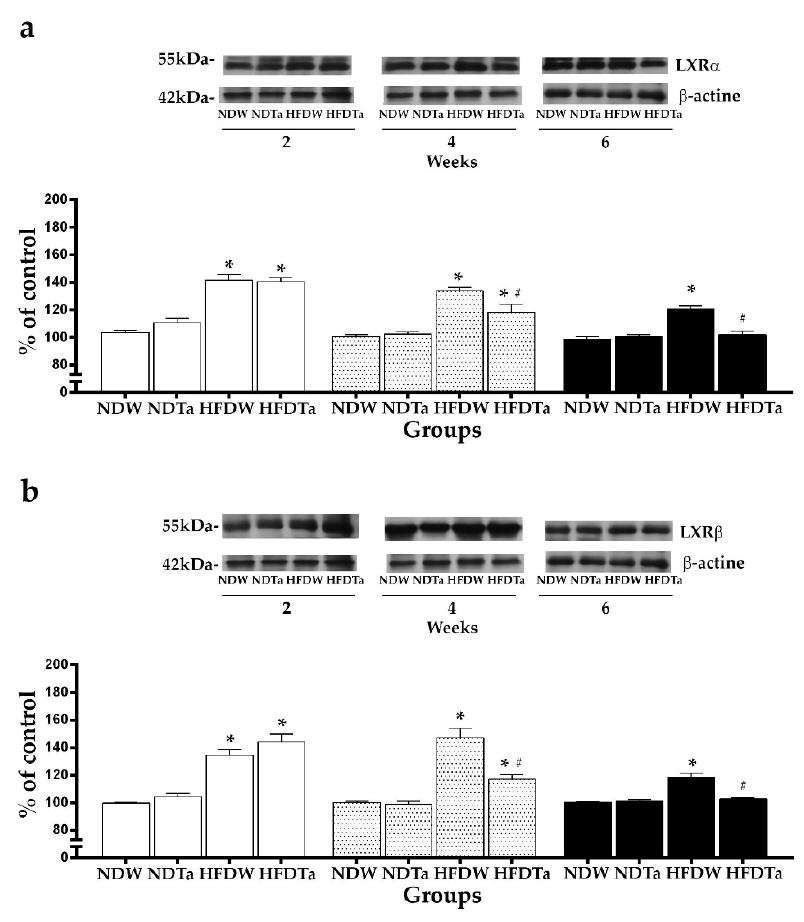
Figure 3. The expression of LXR α ( a ) and LXR β ( b ) in the liver after the administration of W or Ta for 2 (white bars), 4 (dotted bars), or 6 (black bars) weeks. The expression of LXRs was quantified by Western Blot and represented as a percentage of ND. Representative western blots are showed on the top of each graph. Results are expressed as mean ± SEM from two independent assays ( n = 5 animals/group). Significant differences were determined by two-way ANOVA followed by New- man–Keuls’ post-hoc test. * refers to each respective ND and # refers to the HFDW. * ,# p < 0.05 New- man–Keuls’ post-hoc test. Abbreviations: NDW, normal diet + water; HFDW, high-fat diet + water; NDTa, normal diet + Ta; and HFDTa, high-fat diet + Ta.